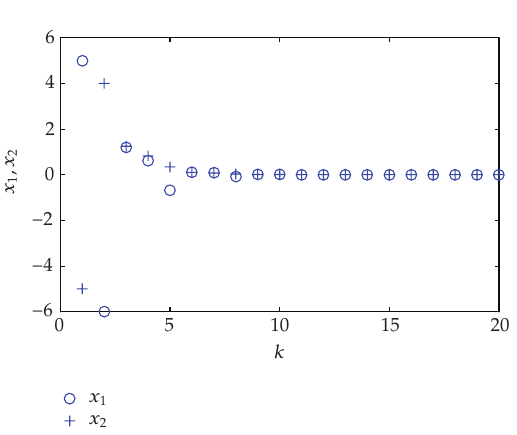
Figure 1: Stability for discrete-time interval